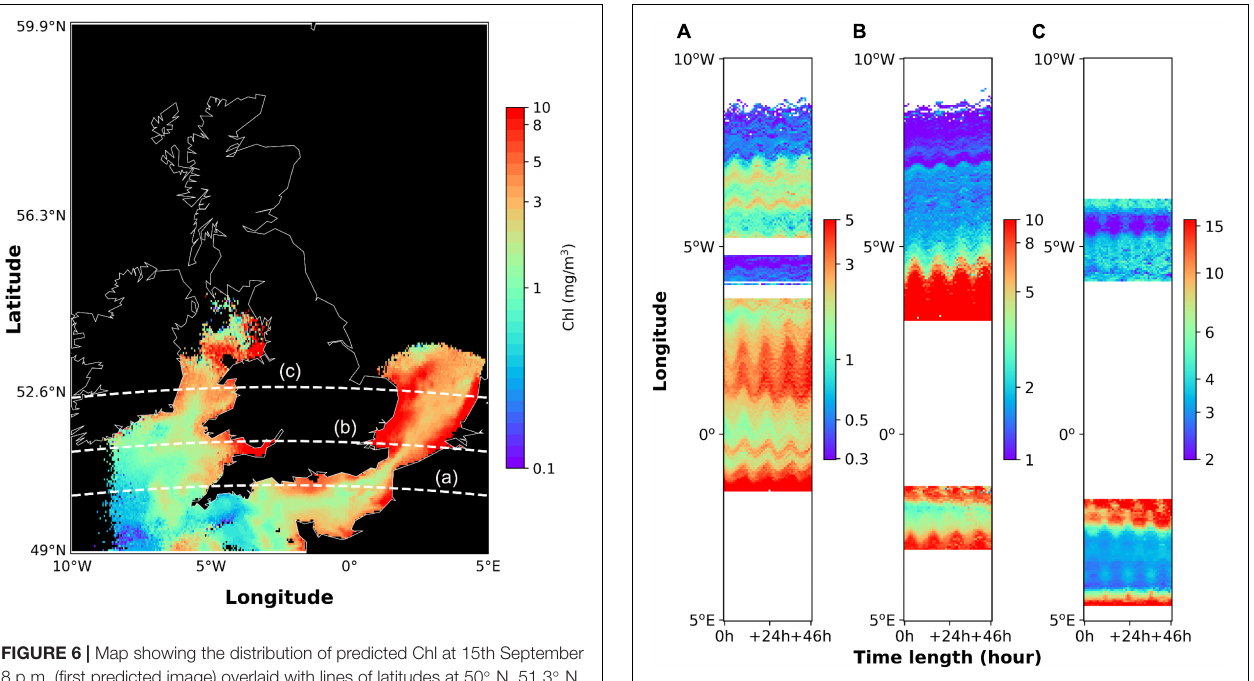
FIGURE 7 | Hovmöller plot showing time series of predicted Chl (mg/m 3 ) along zonal lines: (A) 50 ◦ N, (B) 51.3 ◦ N, and (C) 52.5 ◦ N.